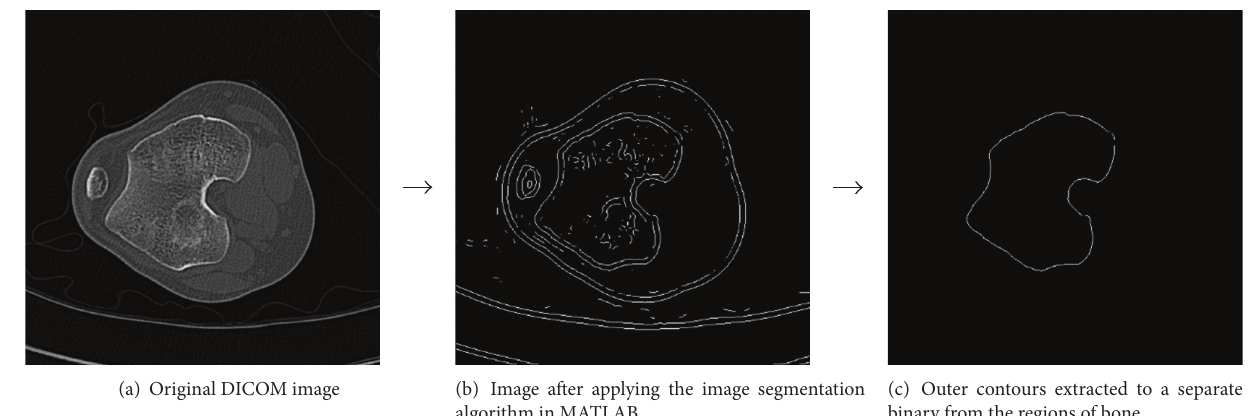
Figure 2: Segmentation procedure for the knee joint by the Laplacian of Gaussian operator algorithm (where input parameters 𝜎 = 4 ).